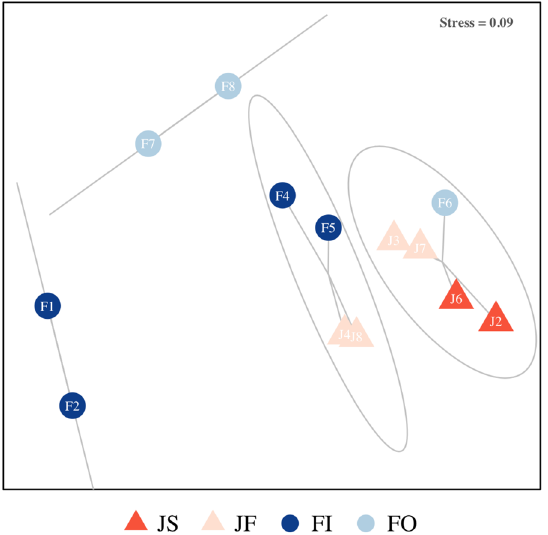
Figure 5. Principle component ordination (PCO) plots based on the Bray-Curtis similarity matrix after square- root transformation of the data from the different areas. JS, Jazan Shore; JF Jazan Far; FI Farasan Inner; FO Farasan Outer.